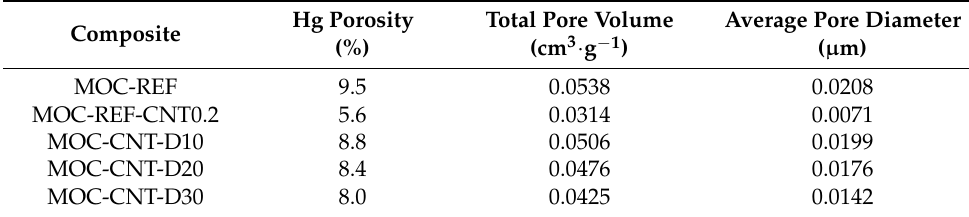
Figure 8. Incremental intruded pore volume. Table 4. Microstructural parameters of the hardened composites determined by MIP.